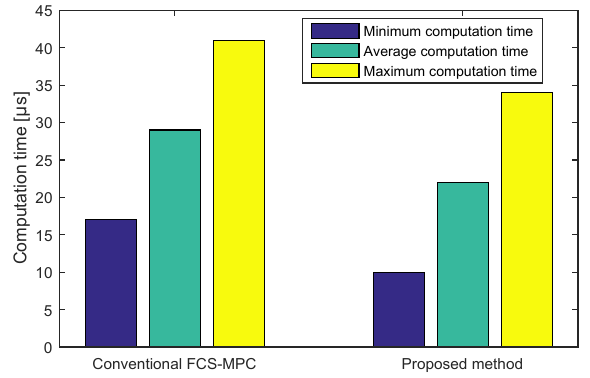
Figure 4. Computation time of two controllers.